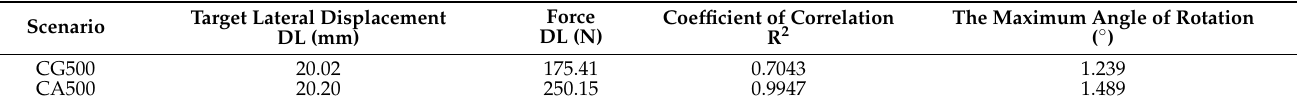
Table 2. Comparing experimental results for scenarios CG500 and